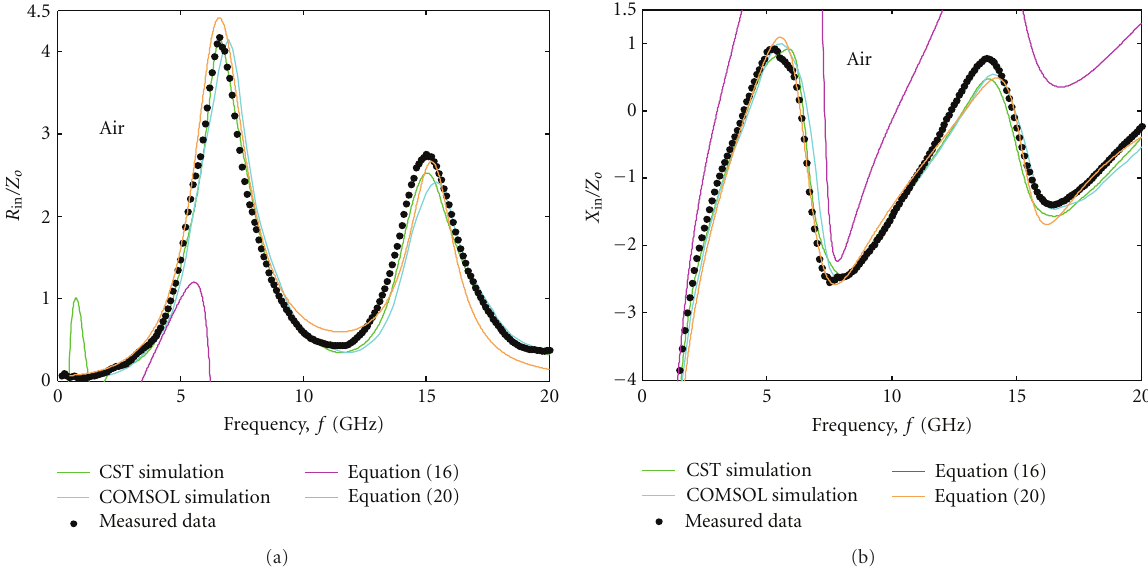
Figure 13: Comparison of (a) normalized resistance, R in /Z o , and (b) normalized reactance, X in /Z o , for air at 25 ◦ C by considering size of probe with a = 0 . 65 mm, c = 2 . 05 mm, and h = 13 . 92 mm.